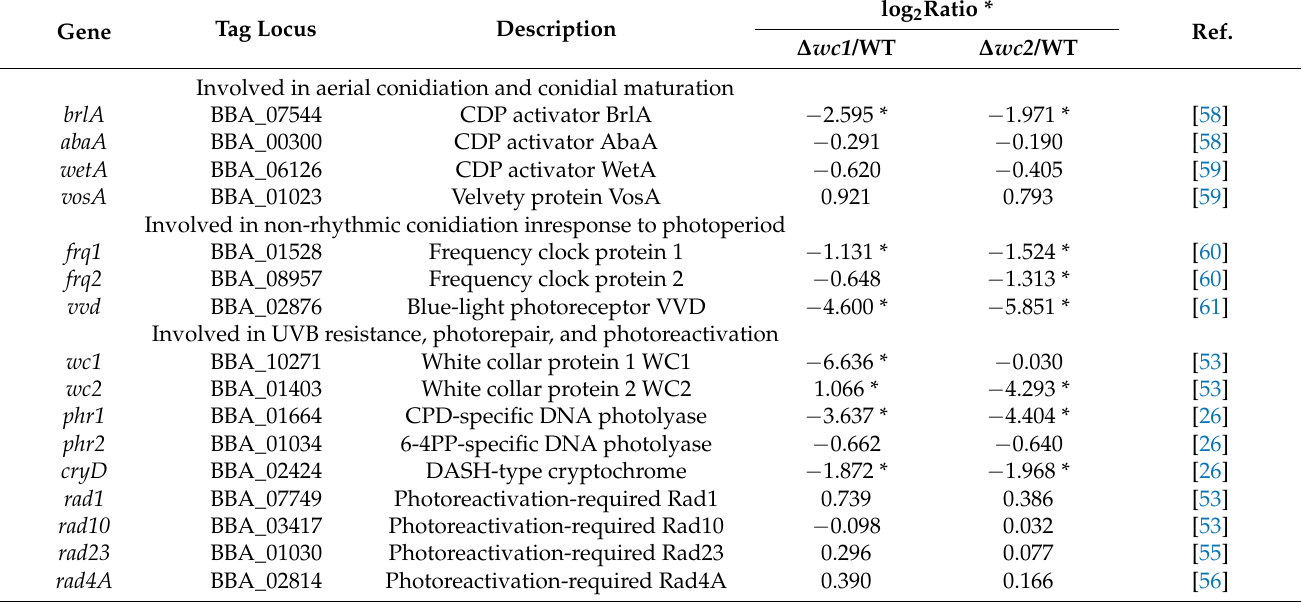
Table 1. The log 2 ratio values of crucial phenotype-related genes in the analyzed